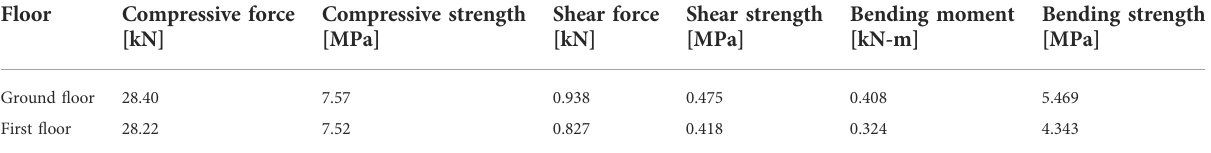
TABLE 4 Stresses due to gravitational load.